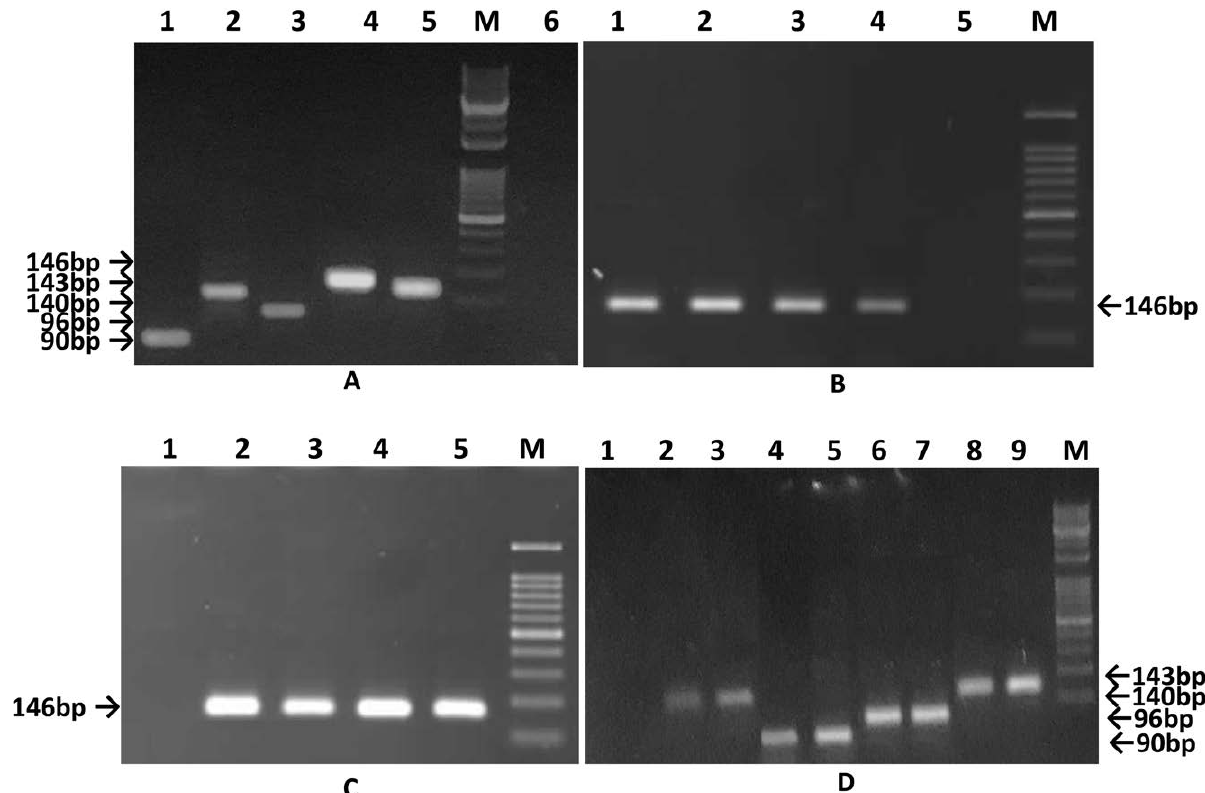
Figure 4. Agarose gel electrophoresis pattern of nested PCR products using P1/P7 primer pair followed by lime witches’ broom phytoplas-